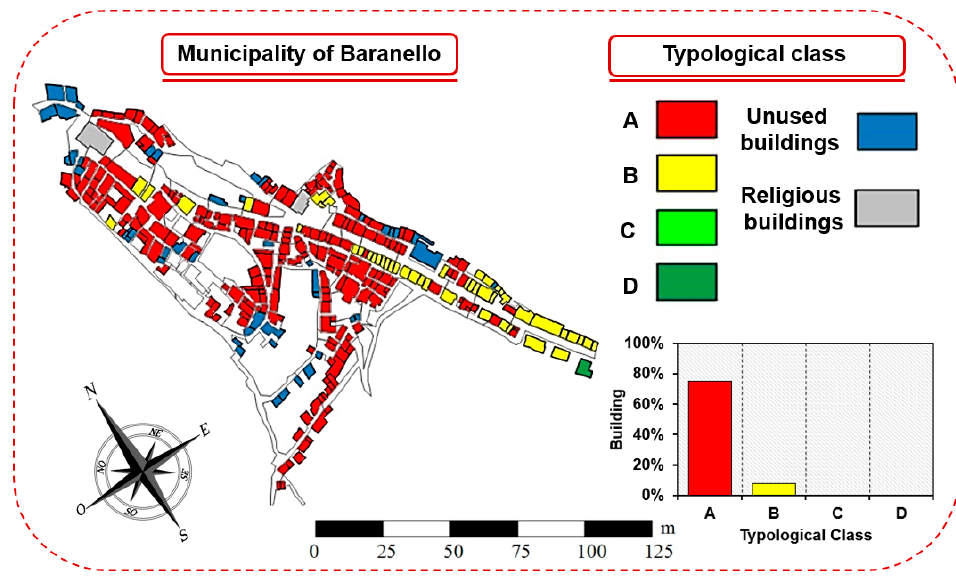
Figure 10. Typological vulnerability classes in the municipality of Baranello.